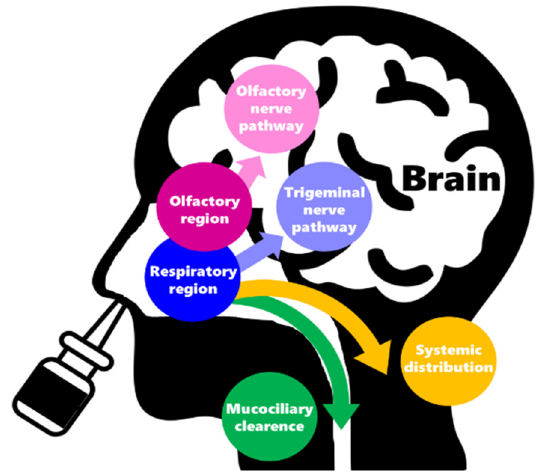
Figure 1. Drug distribution pathways associated with intranasal administration.